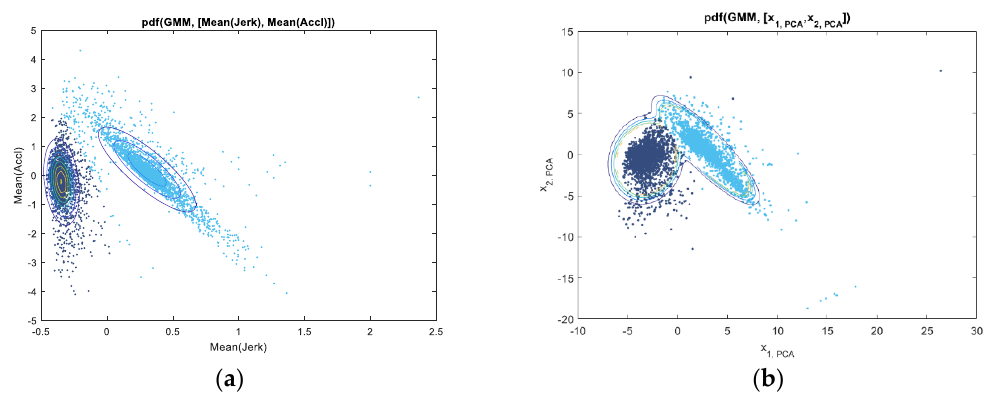
Figure 5. GMM clusters results based on ( a ) original data; ( b ) PCA processed data.